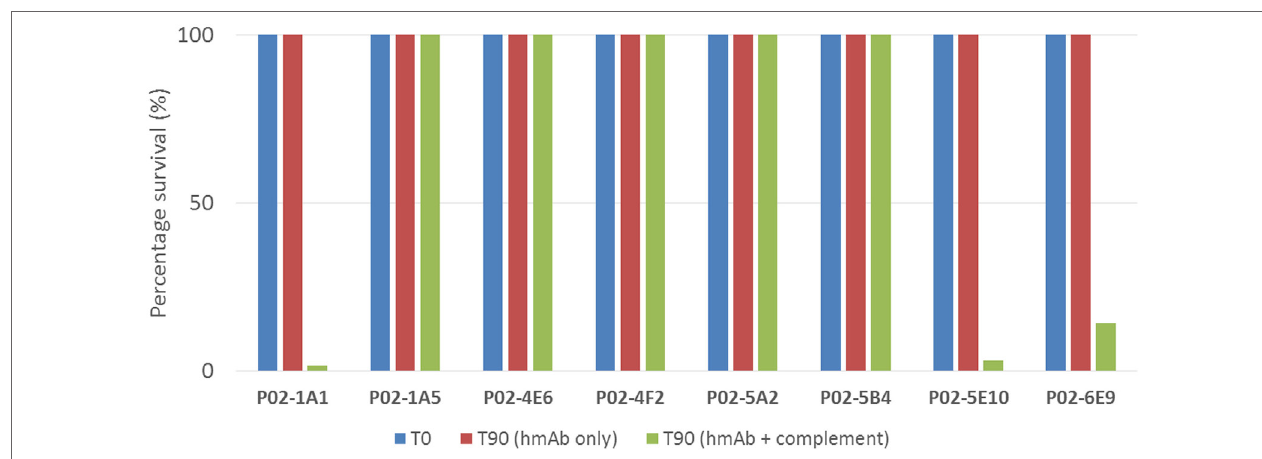
FigUre 5 | SBA of patient-derived antimeningococcal human monoclonal antibodies (hmAbs) versus patient isolate, M14-240312. Assays were performed with hmAbs normalized to final assay concentration of 80 µg/ml, in three biological replicates. Percentage survival after 60-min incubation (T60) in the presence of 25% human complement versus inoculum (T0) is